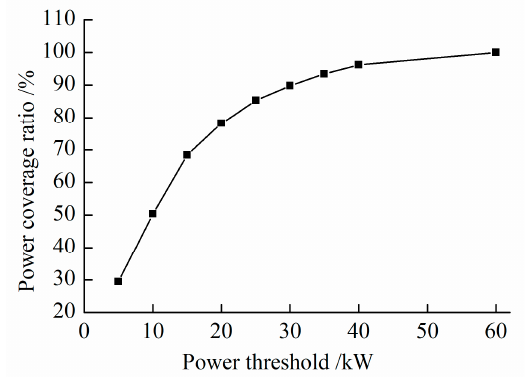
Figure 3. Required power coverage ratio at different power thresholds.